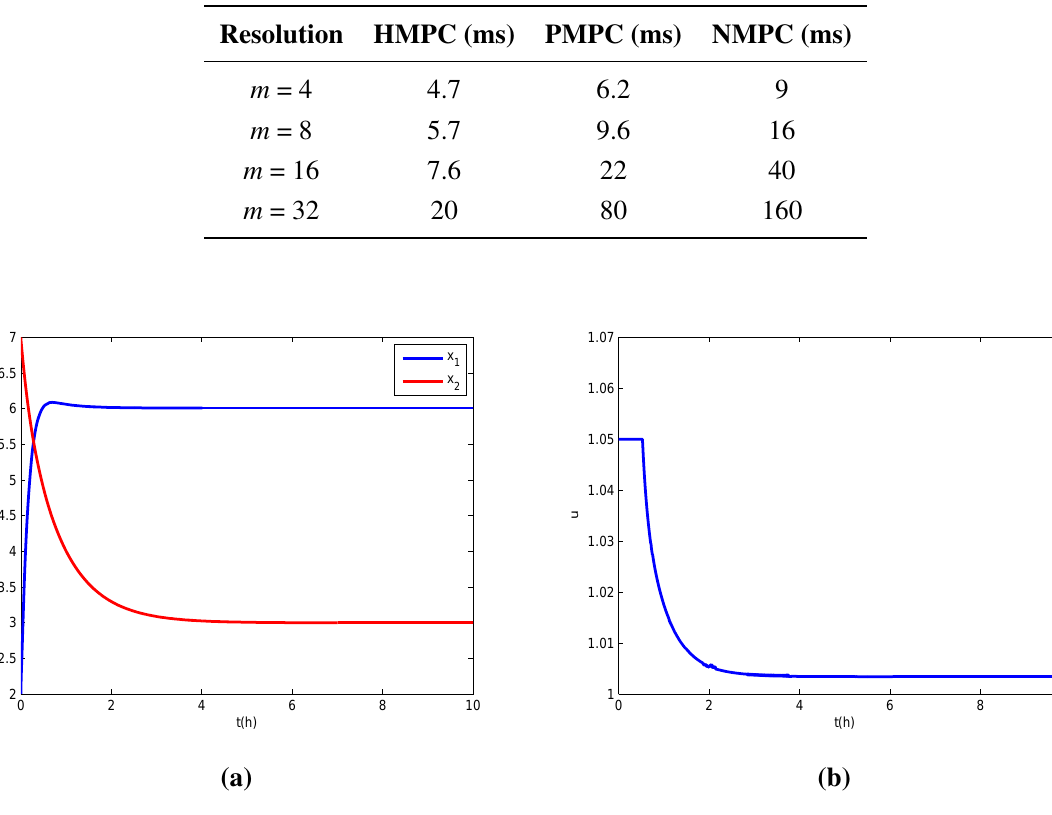
Figure 5. Simulation result under the input constraint with m = 16. ( a ) State trajectory; ( b ) input trajectory.